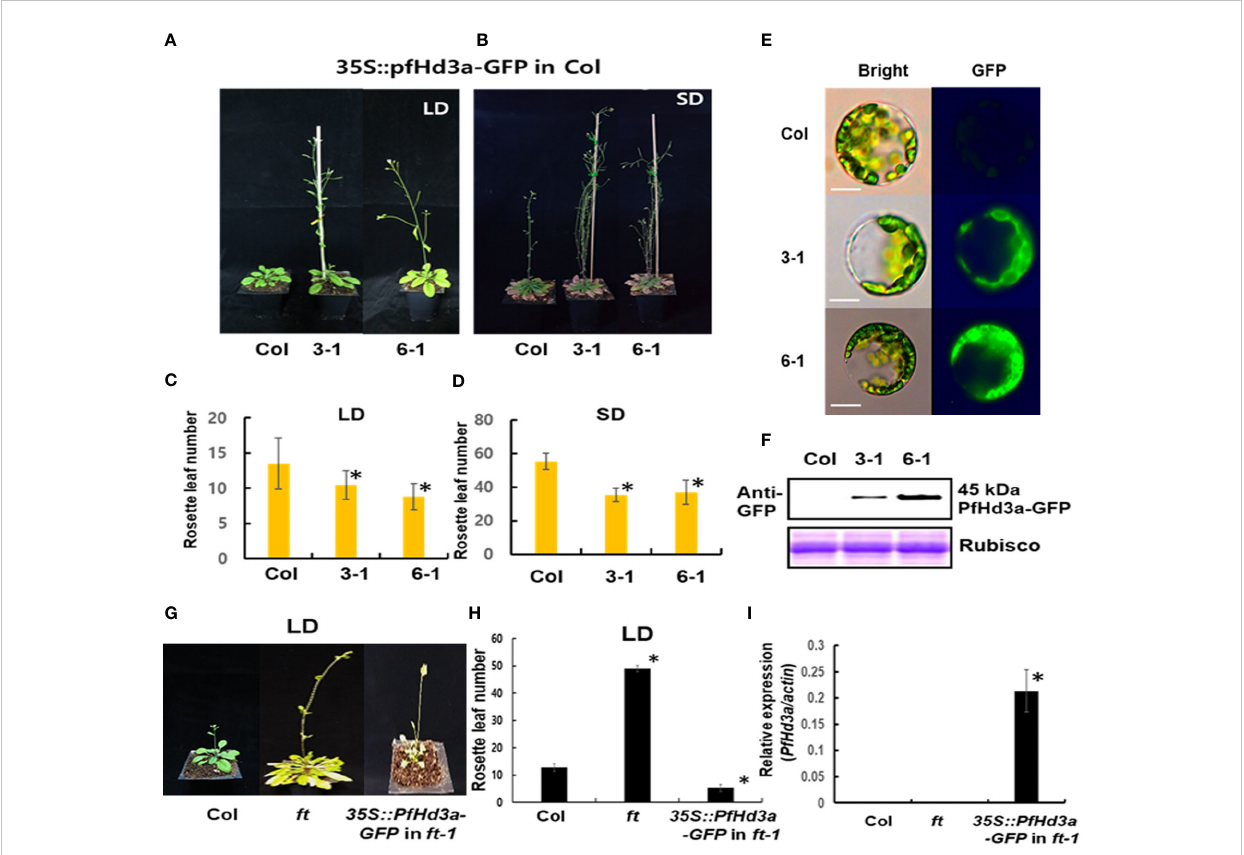
FIGURE 3 Flowering phenotype of overexpressed PfHd3a in Arabidopsis . Early fl owering of 35S: PfHd3a -GFP in LD (A) and SD (B) . Flowering times were determined at total rosette leaf number at the time of fl owering under LD (C) and SD (D) . At least 12 plants of each genotype were used. Statistical signi fi cance was determined by Student ’ s test (*P < 0.001) versus Col. (E) Arabidopsis mesophyll protoplasts were extracted from each genotype and the localization of PfHd3a-GFPs was observed by fl uorescence microscopy. Scale bars = 10 m m. (F) Total proteins were extracted from Col and overexpression lines (3-1, 6-1) and then an immune blot was performed with an anti-GFP antibody. Arabidopsis Rubisco proteins were used as a loading control. (G) Complementation analysis of Arabidopsis ft-1 mutant. 35S:PfHd3a-GFP were transformed in Arabidopsis ft mutant and fl owering phenotype was observed. (H) Flowering times were determined at the total rosette leaf number at the time of fl owering under LD. At least 12 plants of each genotype were used. Statistical signi fi cance was determined by Student ’ s test (*P < 0.001). (I) The levels of PfHd3a mRNA under LD condition determined by qRT-PCR of Samples from 2-week-old plants. Each bar represents an average of two independent replicate experiments. The error bar indicates the standard deviation. Statistical signi fi cance was determined by Student ’ s test (*P <